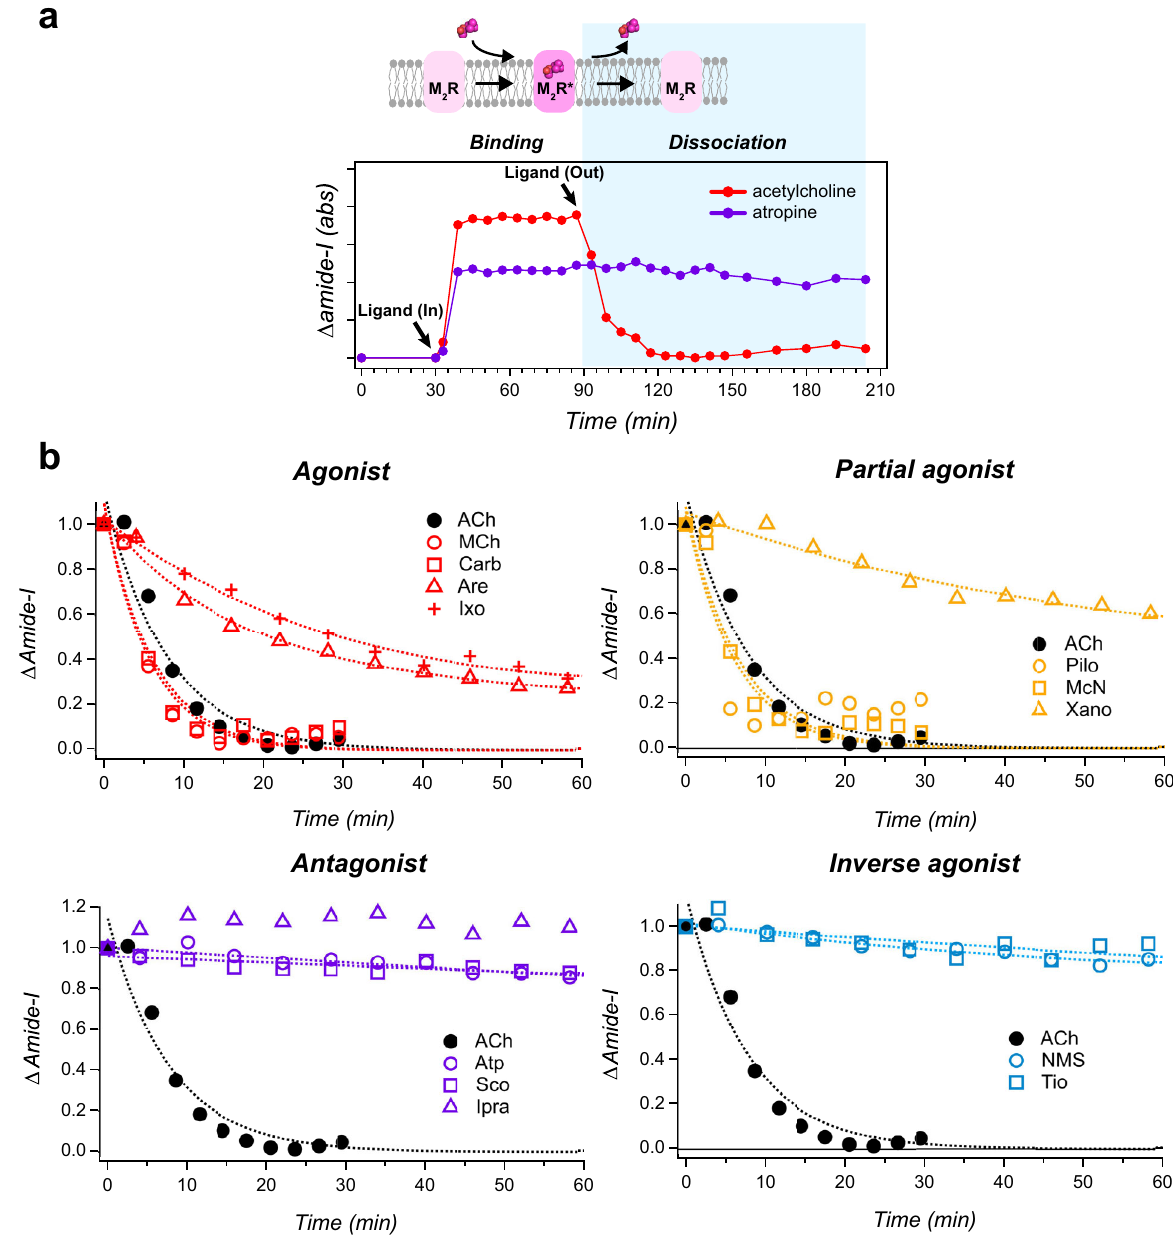
Fig. 4 Ligand-dependent dissociation kinetics on M 2 R. a Time trace of the integrated absorbance signal in the amide-I band (red circle, ACh; purple circle, Atro) taken from Katayama et al. 35 . Each ligand (1 mM concentration) is added at 30 min time point and is washed out at 90 min time point by exchanging to the buffer without ligand at a fl ow rate of 0.6 mL min − 1 through a fl ow cell, of which the temperature is maintained at 20 °C by circulating water. The arrows in the illustration mark the time points of ligand-In and ligand-out via buffer exchange, respectively. Ligand dissociation phase is highlighted by light blue. b Time trace of the integrated absorbance signal at dissociation phase in the amide-I band for each ligand. Time-dependent difference ATR-FTIR spectra upon ligand dissociation in the amide-I region (1680 – 1630 cm − 1 ) are shown in Supplementary Fig. 10. Black red, orange, purple, and cyan correspond to ACh, agonist, partial agonist, antagonist, and inverse agonist, respectively. Dotted lines represent the fi tting curve obtained by single exponential